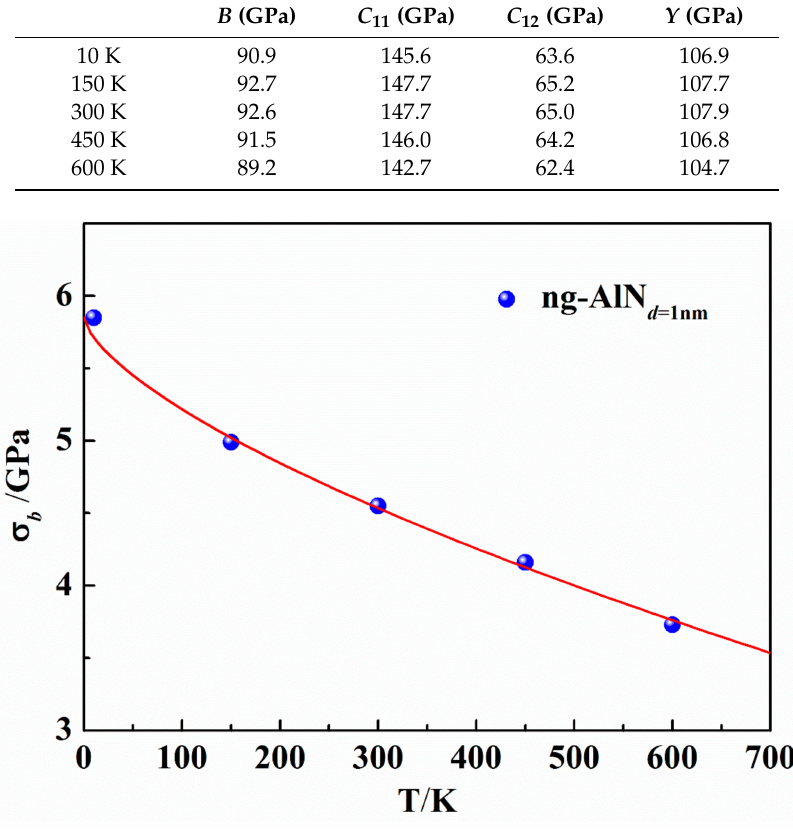
Figure 7. Ultimate strength as a function of temperature ( T ) for ng-AlN d = 1